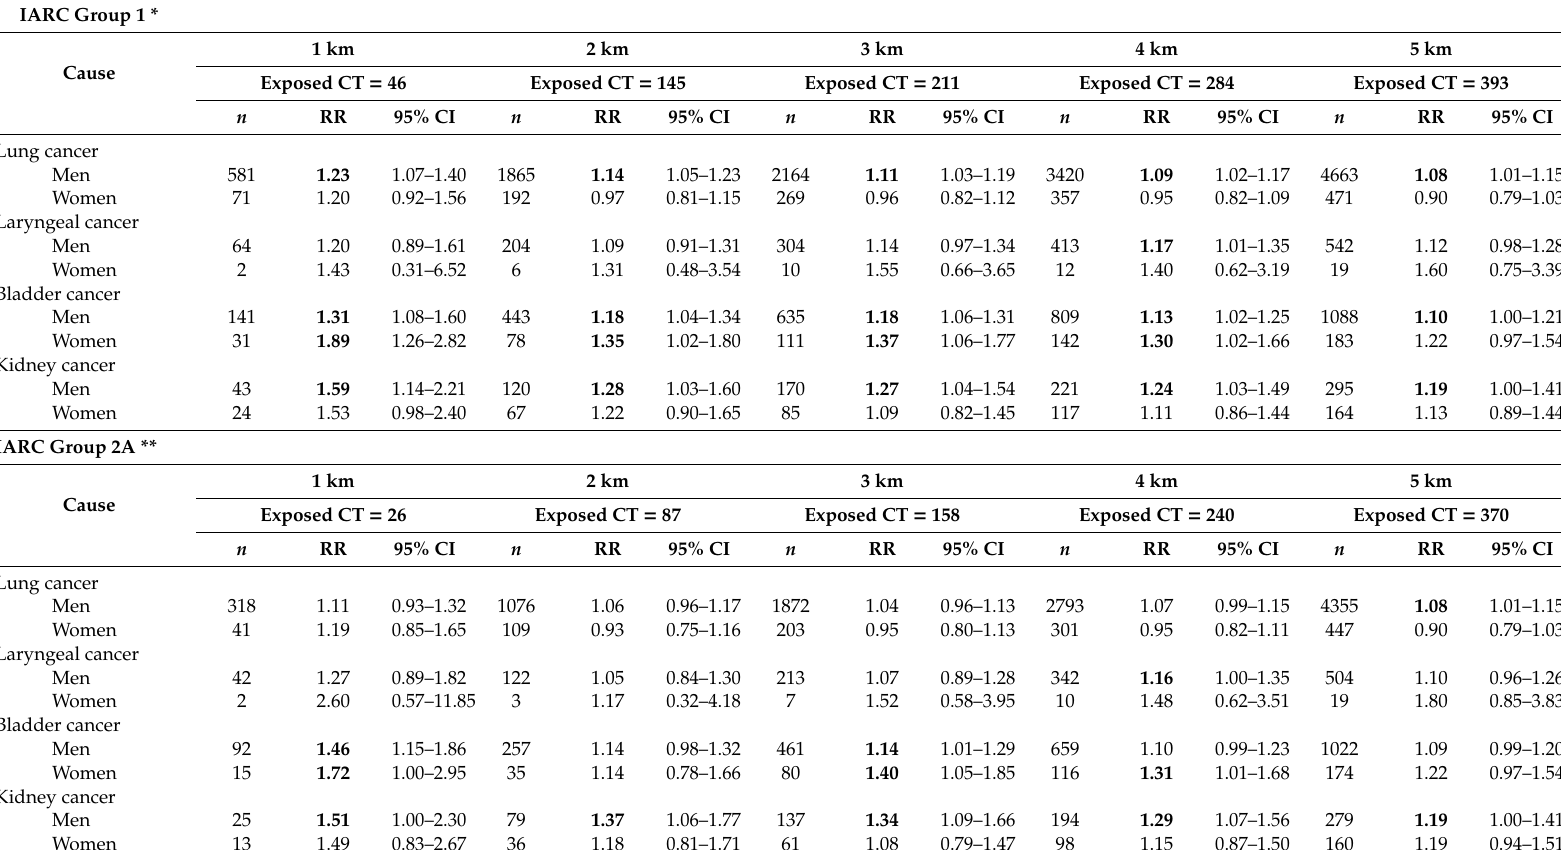
Table 4. RRs of mortality from lung, laryngeal, bladder and kidney cancers adjusted for deprivation index in census tracts situated near polluting industrial facilities that release Groups 1 and 2A